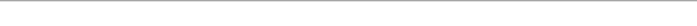
(See figure on next Fig. 6 Pharmacologically inhibiting the PDGF‑BB/PDGFRβ signaling pathway facilitates functional recovery and axonal regeneration after SCI. a Scheme of the experimental setup. Imatinib or PBS was injected intrathecally every day from 4 h until 28 days post‑injury (dpi). b Behavioral testing using the BMS score was performed at the indicated time points. c , d Footprint assays ( c ) and quantitative analysis ( d ) in mice treated with PBS or imatinib at 28 dpi. e Low‑power photographs of intact spinal cord tissue in mice treated as above at 28 dpi. f Representative immunofluorescence images of GFAP (green) and 5‑HT axons (red) in mice treated as described above at 28 dpi. Right panel show high magnification images in the dotted box on the left panel. g Quantification of the lesion distance to the 5‑HT axon tip. h , k Representative immunofluorescence images of GFAP (green), NF‑H fibers (red), GAP43 fibers (red), and NeuN + neurons (red) in Z1‑Z3 zones adjacent to the lesion core in mice treated as above at 28 dpi. Right panel show brightfield image (upper) and high magnification image (lower) in the dotted box in the left panel of h . Scale bars: 200 μm ( e ), 100 μm (left panel in f and h , right upper panel in h and k ), and 20 μm (right panel in f and right lower panel in h ). i , j , l Quantification of NF‑H intensity ( i ), GAP43 intensity ( j ), and NeuN + neurons numbers ( l ). Data are expressed as mean s.e.m. n 5–7 per time point or per group. All ± = images are from sagittal sections. * p < 0.05, ** p < 0.01, and *** p < 0.001 versus control by two‑way ANOVA followed by Bonferroni’s post hoc test in b and l . ** p < 0.01 and *** p < 0.001 versus control by unpaired two‑tailed Student’s t test in d , g , i , and j